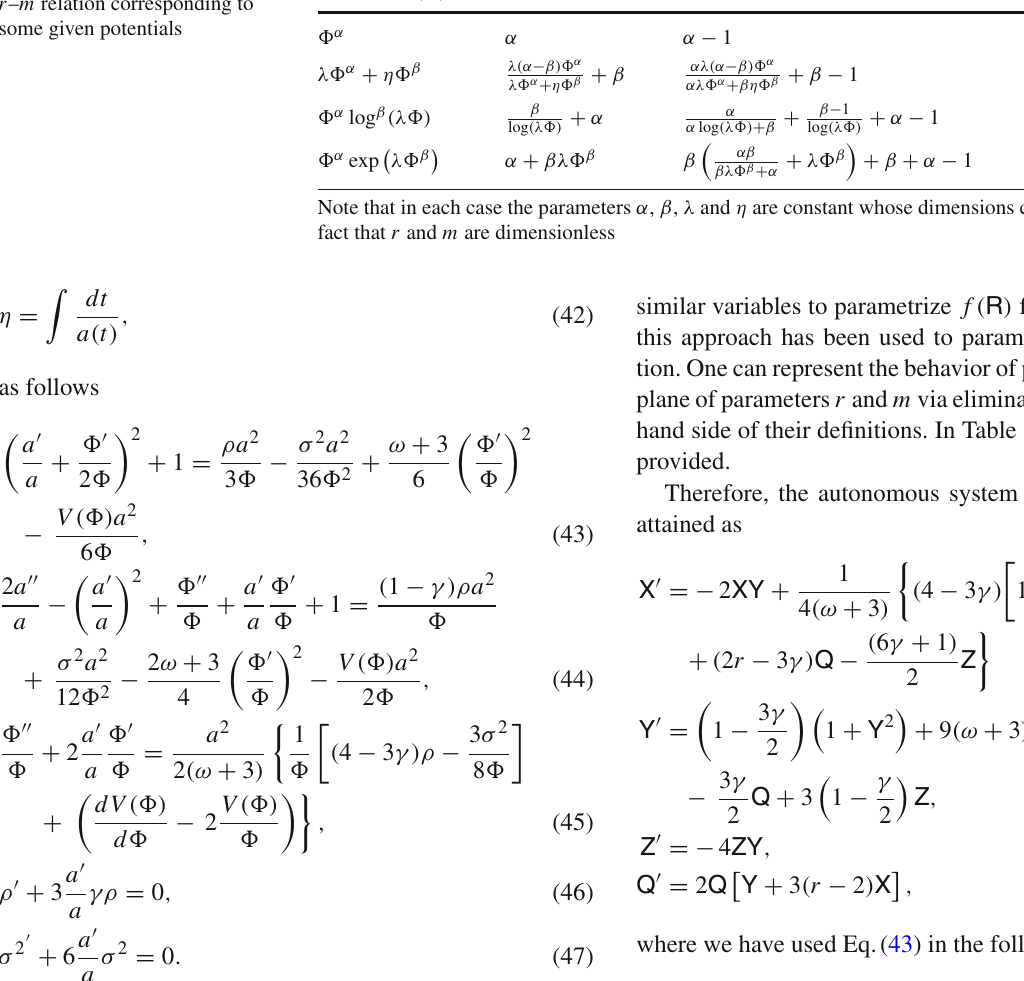
Table 1 The corresponding r – m relation corresponding